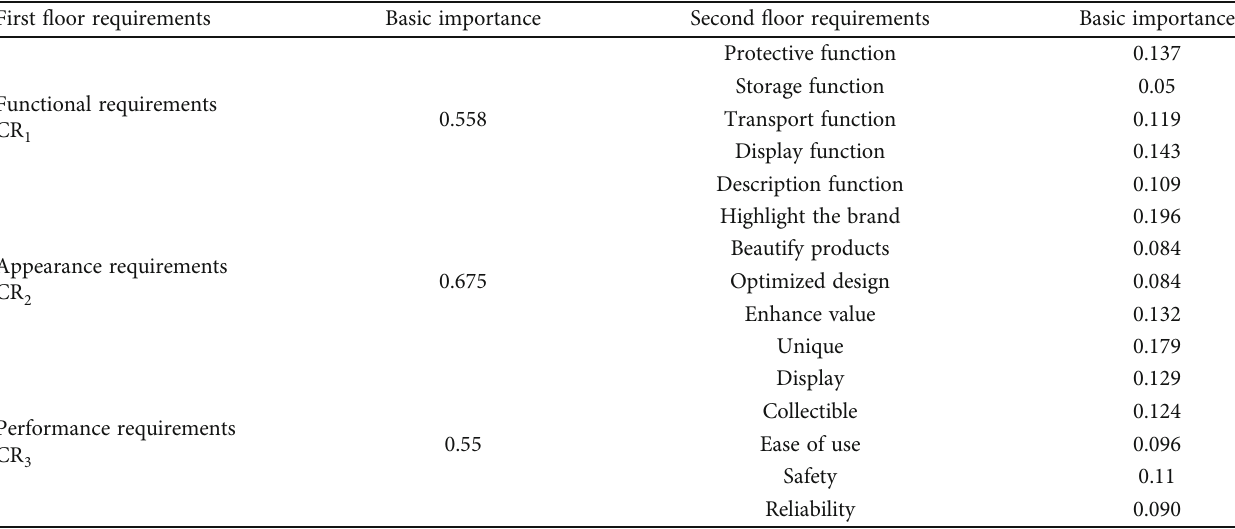
Table 6: Importance of consumers ’ requirements for jewelry